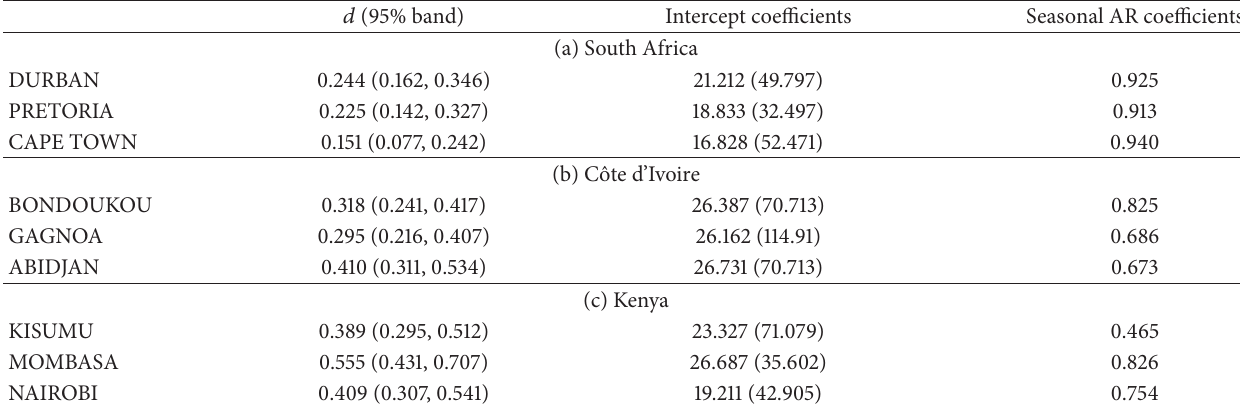
Table 3: Estimated coefficients on the selected model.